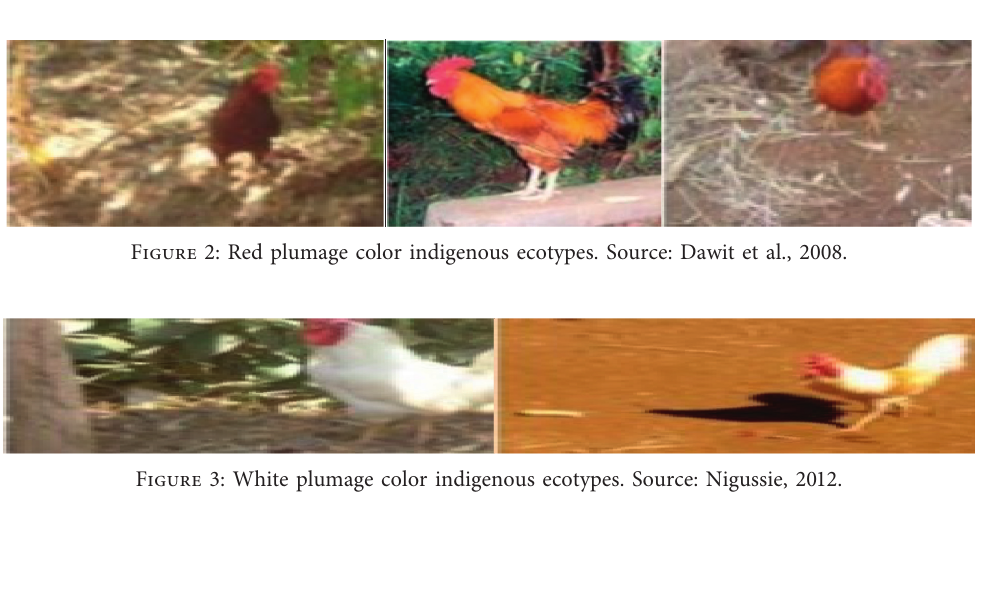
Figure 1: Barley plumage color indigenous ecotypes. Source: Solomon, 2008.